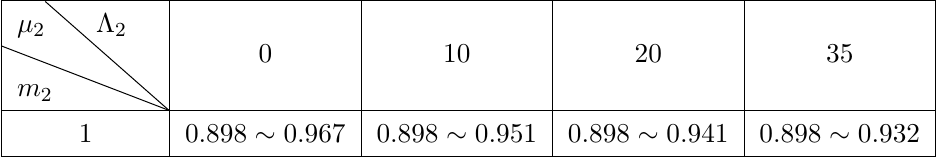
Table 4 . The domain of existence of the mass µ 2 of the scalar field φ 2 for different values of Λ 2 with the azimuthal harmonic index m 2 = 1 . All solutions have µ 1 = 1 and m 1 = 1